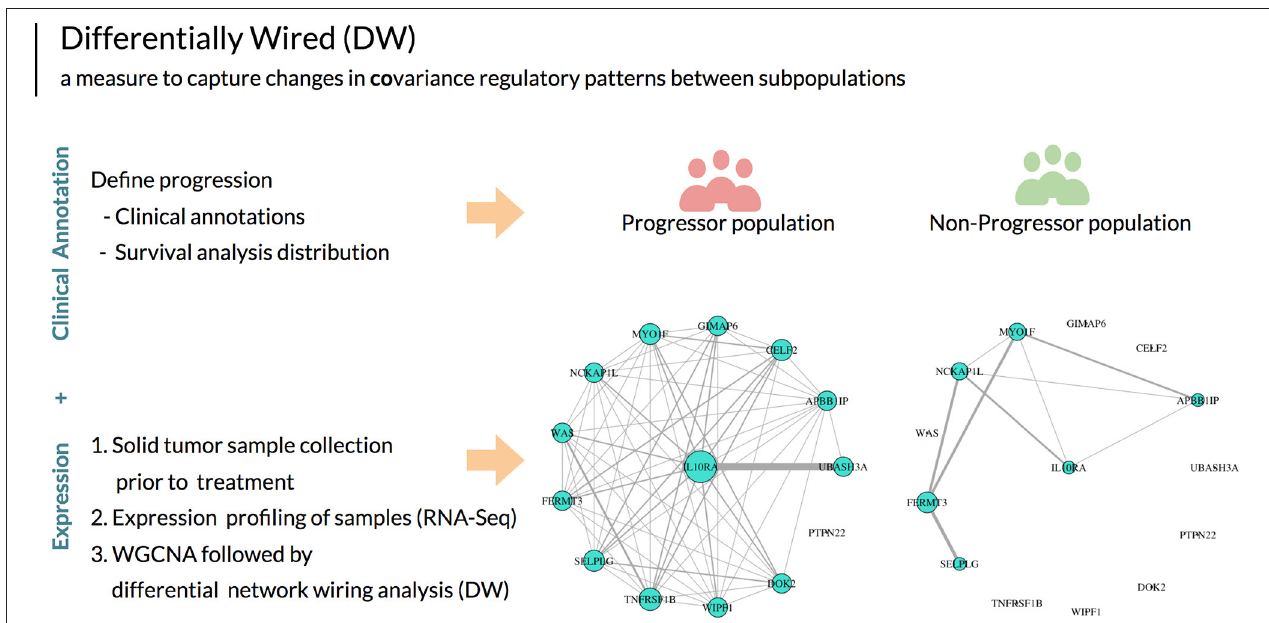
FIGURE 1 | After defining disease progression based on clinical outcomes, using this annotation in aggregate with expression data and network analysis we can then utilize the unit of measure differential wiring (DW) to guide patient stratification. This measure detects changes in the collective transcriptional profiles of groups of genes between patient populations. These genes do not necessarily exhibit differential expression or variability. DW allows for identifying a correlation change of a gene with all other genes between two patient populations. In this example, the network edges indicate gene expression correlation measures. The size of each gene node indicates overall connectivity strength. In this example, striking differences in the co-expression networks are seen between HNSCC progressors and non-progressor for a particular gene ( IL10RA ).